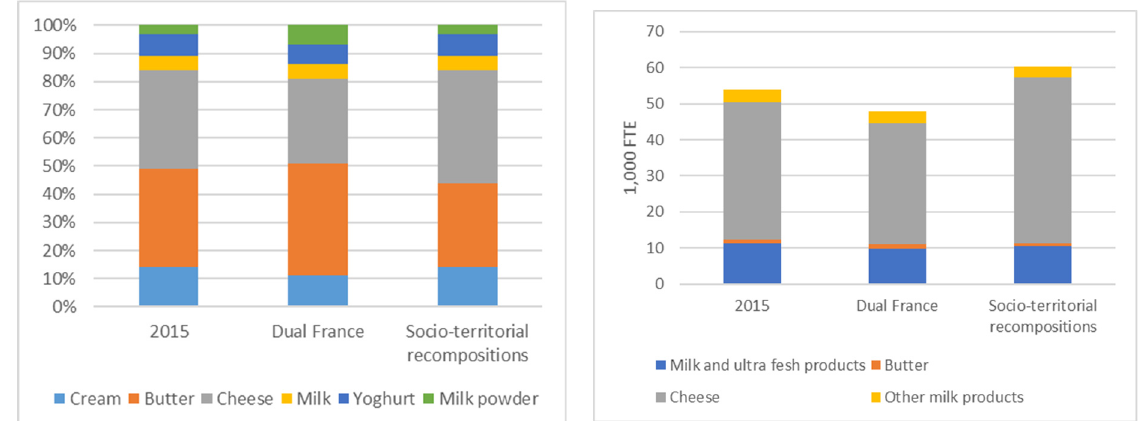
Figure 7. Evolution of the product mix and associated jobs in the dairy sector for the two scenarios Dual France and Socio-territorial recompositions.